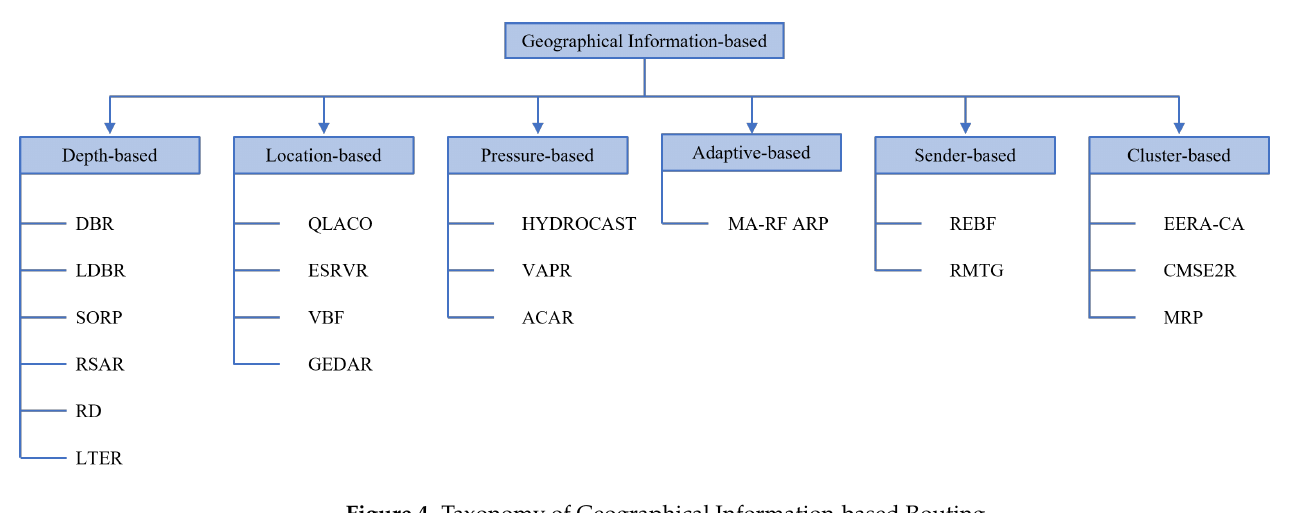
Figure 4. Taxonomy of Geographical Information-based